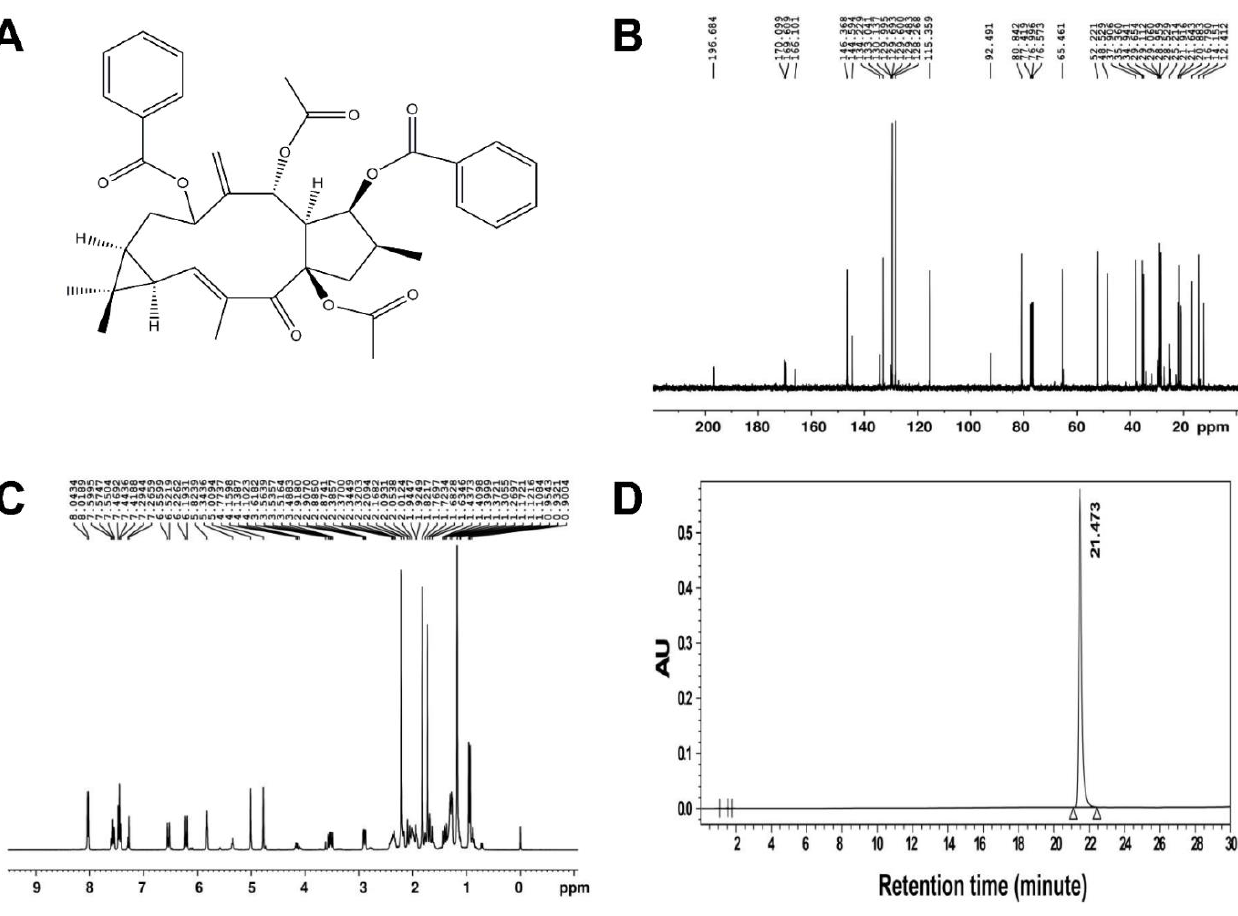
Figure 8. ( A ) The chemical structure of EFL2. The nuclear magnetic resonance spectra of EFL2. The left panel was the 13 C spectra ( B ), and the right panel was the 1 H spectra ( C ). The purity of EFL2 detected by HPLC ( D ). Chromatographic conditions: Gemini C18 column (250 × 4.6 mm, 4 μm particle size); mobile phase of methanol:water = 65:35; flow rate: 1.0 mL/min; detection wavelength: 250 nm; column temperature: 35 °C; injection volume: 5 uL; injection concentration: 2 mg/mL in metha-